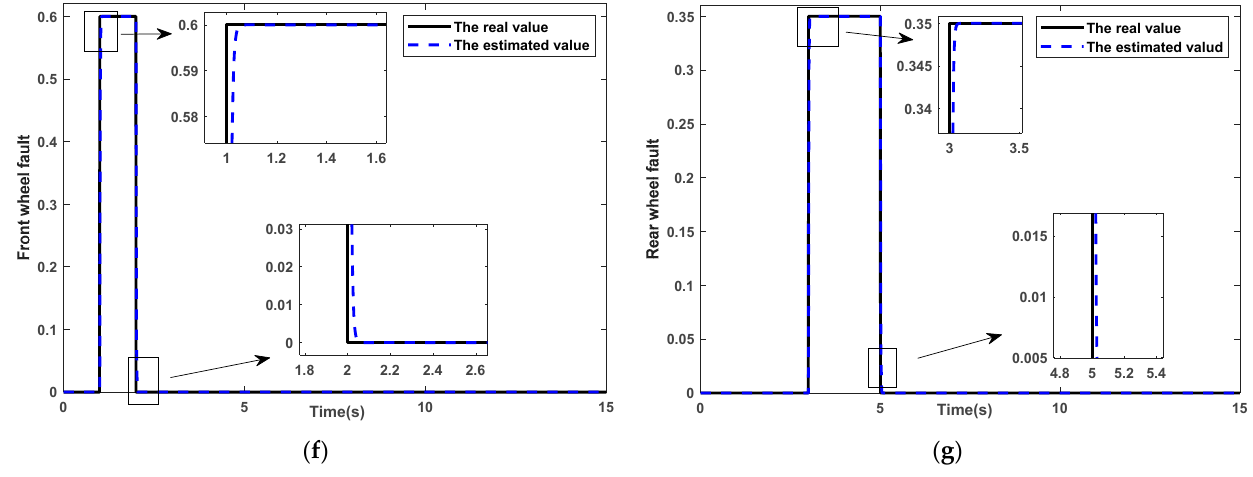
Figure 2. The response curve of the system. ( a ) The curve of front and rear wheel angles. ( b ) The curve of the yaw rate. ( c ) The curve of side slip angle. ( d ) The error curve of the yaw rate. ( e ) The error curve of side slip angle. ( f ) The curve of front wheel fault. ( g ) The curve of rear wheel fault.